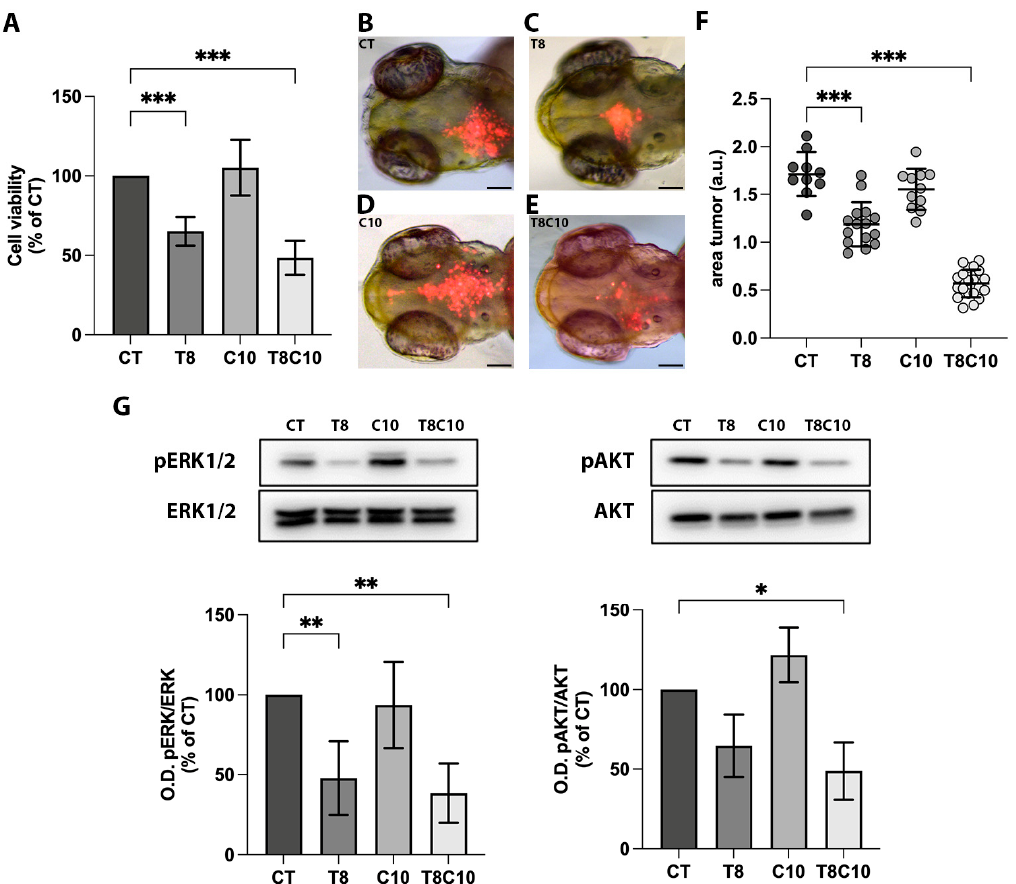
Figure 1. Hh and HDAC6 inhibition impaired U87-MG cell viability. ( A ) MTT assay of U87-MG cells treated for 48 h with vehicle (CT), 8 µ M of TubA (T8), 10 µ M of cyclo (C10) and 8 µ M of TubA + 10 µ M cyclo (T8C10). ( B – E ) Representative images of the head region of 3 dpf zebrafish embryos xenotransplanted with labeled U87-MG cells pretreated with ( B ) CT, ( C ) T8, ( D ) C10, and ( E ) T8C10. ( F ) Quantification of the tumor area at t1 (24 h postinjection, hpi) normalized to the tumor area at t0 (immediately after U87 injection). ( G ) Western blot analyses and quantification of pERK and pAKT protein expression levels following 48 h treatments with or without T8 and C10, alone or in combination. Data are expressed as the percentage of the control ( A , G ) or mean ± standard deviation ( F ). CT—vehicle; TubA/T—tubastatin A; cyclo/C—cyclopamine. One-way ANOVA with Tukey post hoc correction. *** p < 0.001; ** p < 0.01; * p < 0.05; nonsignificant data are not shown. Scale bare indicates 100 µ m.